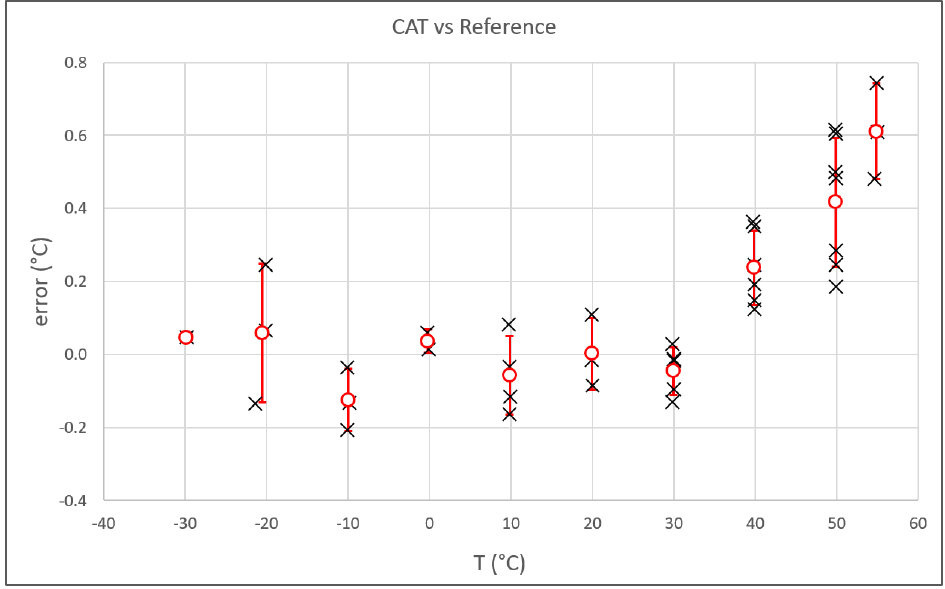
Figure 8. Summary of the results: the measurement difference between the CAT and the reference thermometers is plotted vs. the temperature. The red circles represent the average of the results for each temperature. The vertical red bars are the standard deviation of the differences.